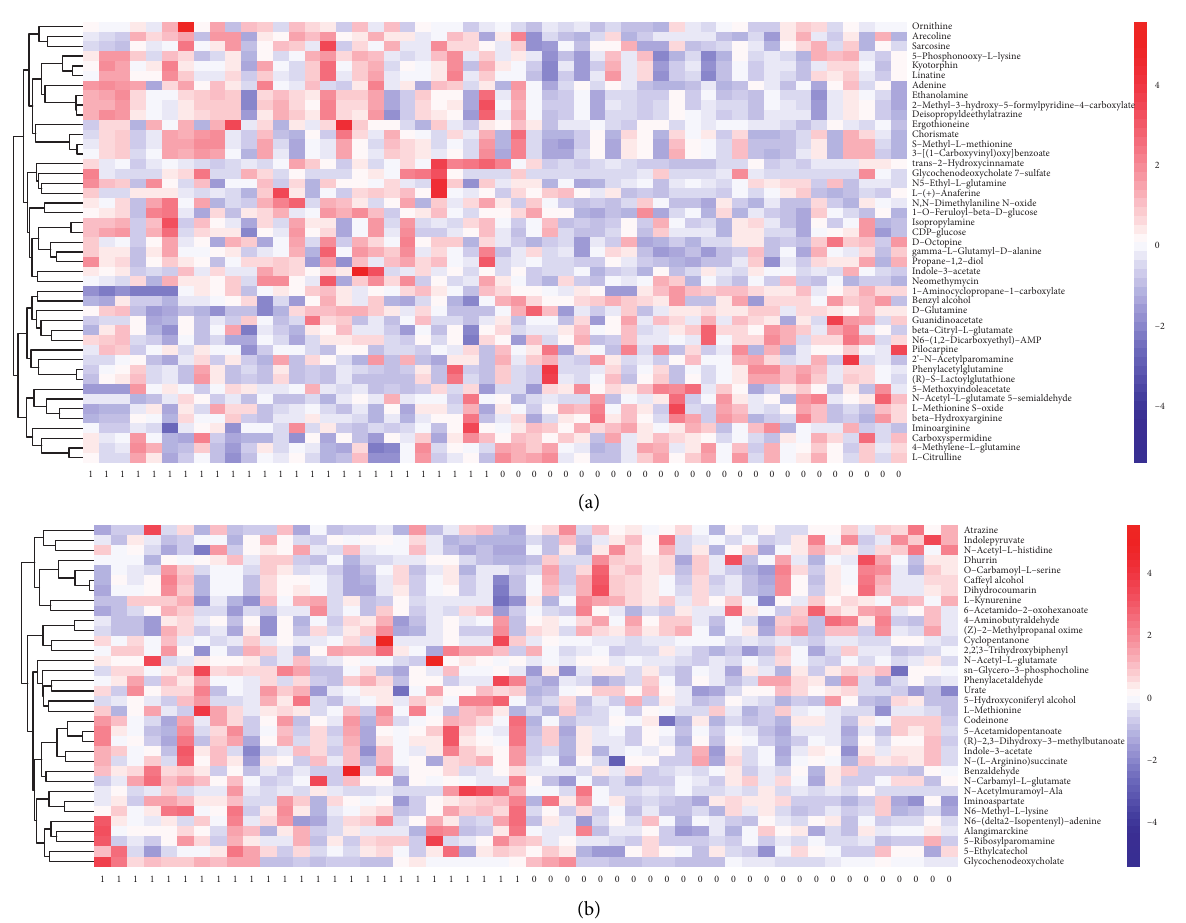
Figure 1: Heatmap of metabolites between hypertensive and normotensive children as detected by the (a) positive mode (1: hypertension; 0: normal blood pressure) and (b) negative mode.